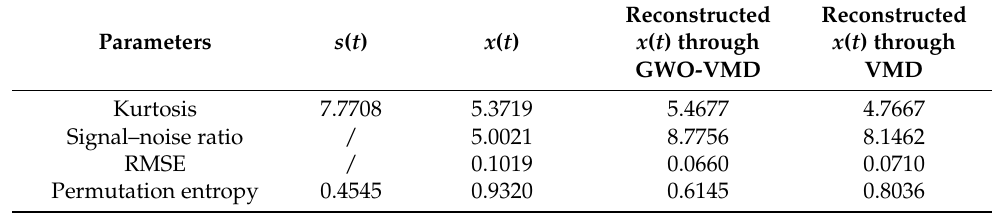
Table 5. Characteristic parameter comparison of the experimental